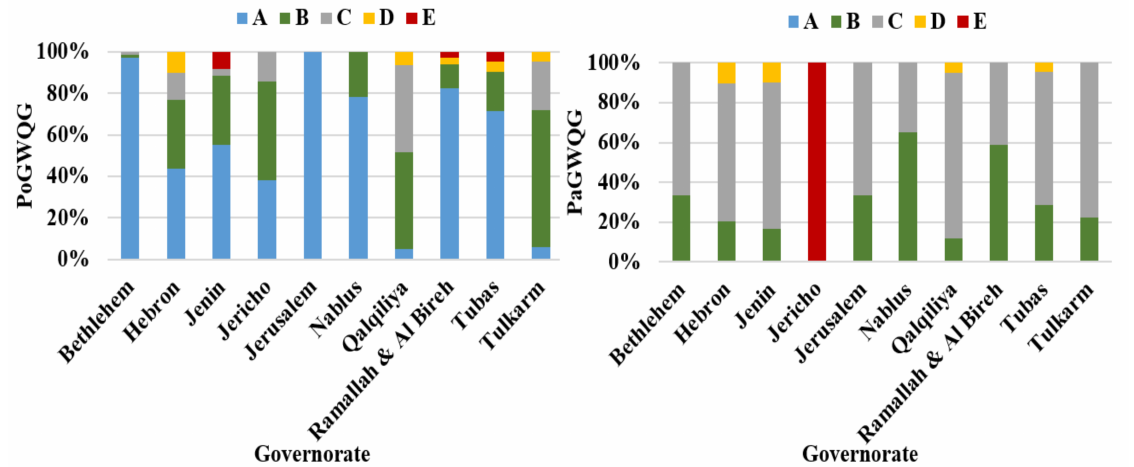
Figure 7. PoGWQGs and PaGWQGs cross the West Bank